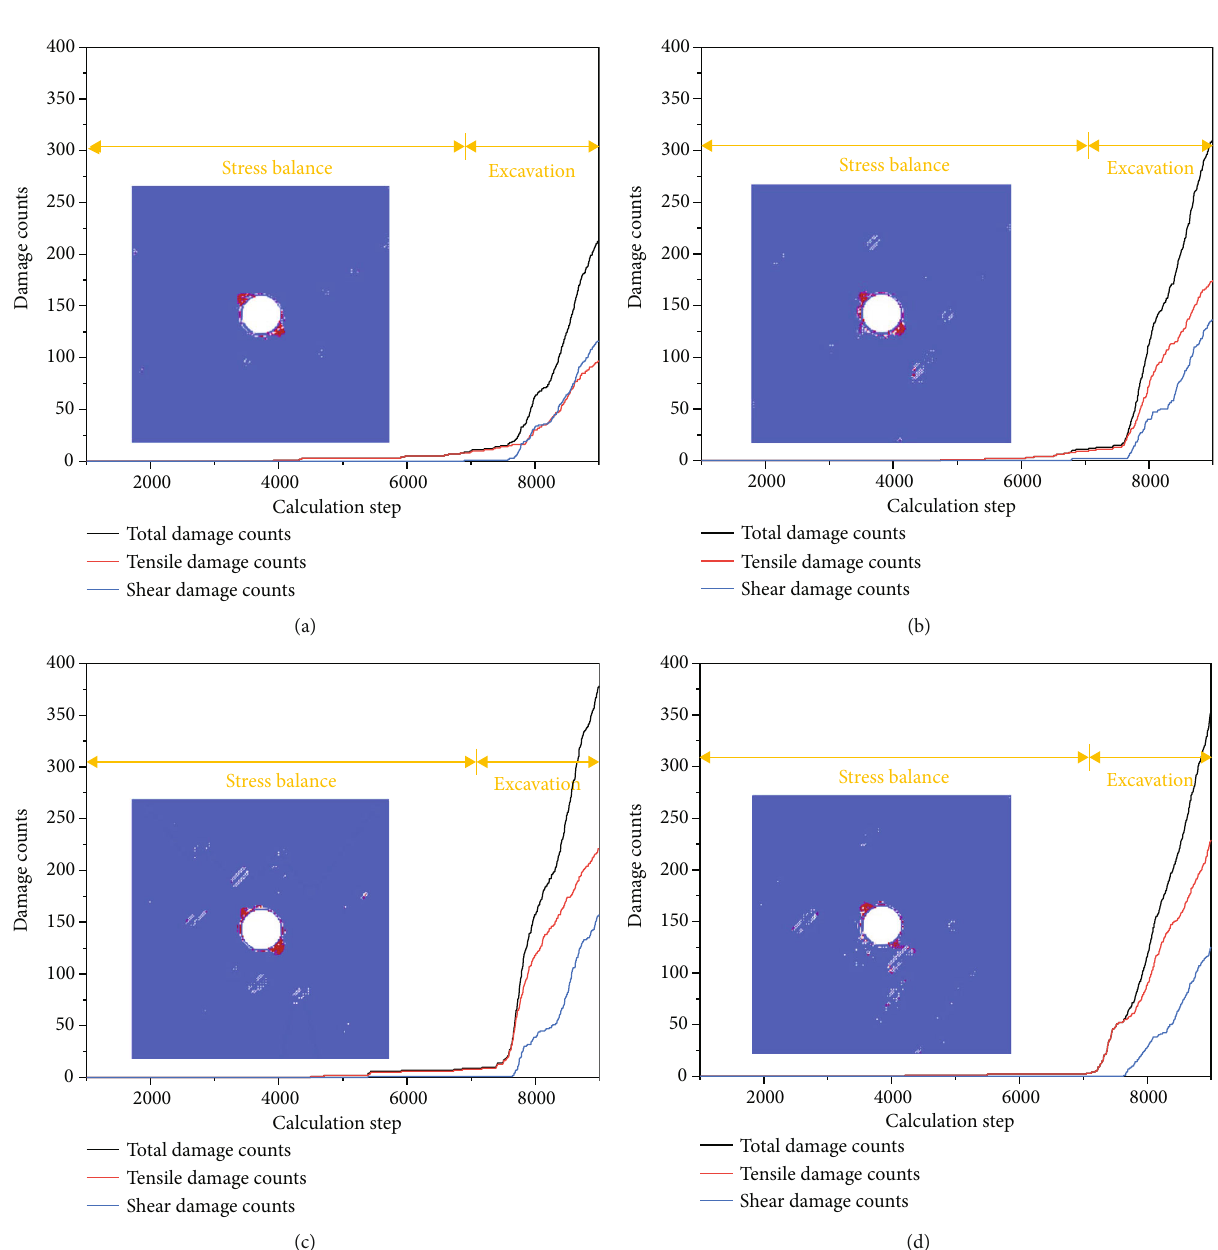
Figure 11: Excavation damage range under di ff erent fi ssure lengths. (a) f l = 3m . (b) f l = 6m . (c) f l = 9m . (d) fl = 12 m .